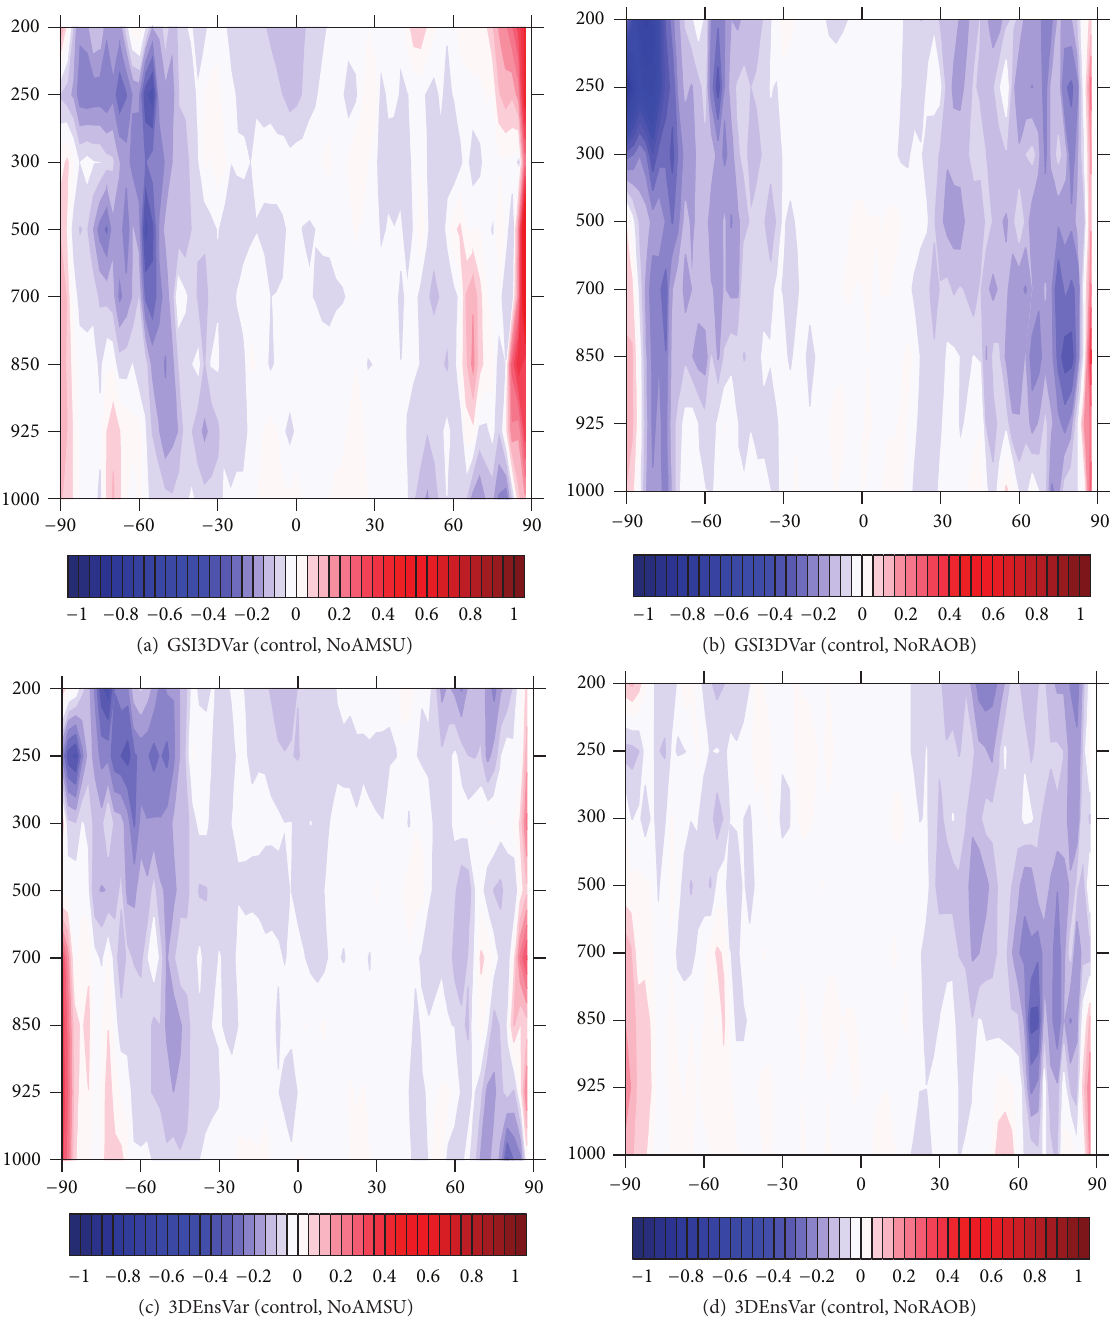
Figure 7: Zonally averaged root-mean-square error difference for 72 hr temperature forecast (K) between (a) GSI3DVar and GSI3DVar- NoAMSU, (b) GSI3DVar and GSI3DVar-NoRAOB, (c) 3DEnsVar and 3DEnsVar-NoAMSU, and (d) 3DEnsVar and 3DEnsVar-NoRAOB. Color definitions are the same as in Figure